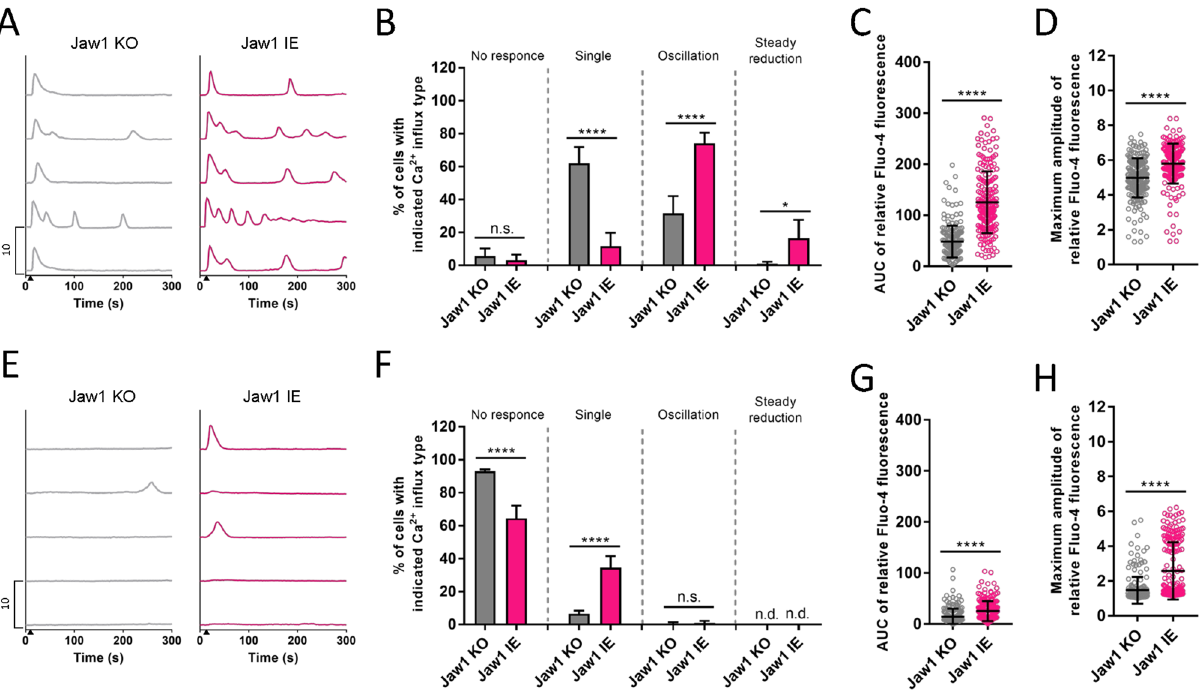
Figure 3. The Jaw1 augmentative effect on the Ca 2+ influx is maintained even under weak GPCR stimulation. ( A , E ) Five representative relative Fluo-4 fluorescence intensity responses to the stimulation with 1 µM ( A ) or 0.3 µM ( E ) ATP out of 200 cells. The closed triangles show the time point of ATP stimulation. ( B , F ) Ca 2+ influx type classification in each cell line upon stimulation with 1 µM ( B ) or 0.3 µM ( F ) ATP. The ratios were calculated based on the average of four independent wells. ( C , D , G , H ) Graph representing the AUC ( C , G ) and maximum amplitude ( D , H ) of the relative Fluo-4 fluorescence intensity in each cell line upon stimulation with 1 µM ( C , D ) or 0.3 µM ( G , H ) ATP in 200 cells. The error bar shows ± S.D.; **** p < 0.0001. Student’s t